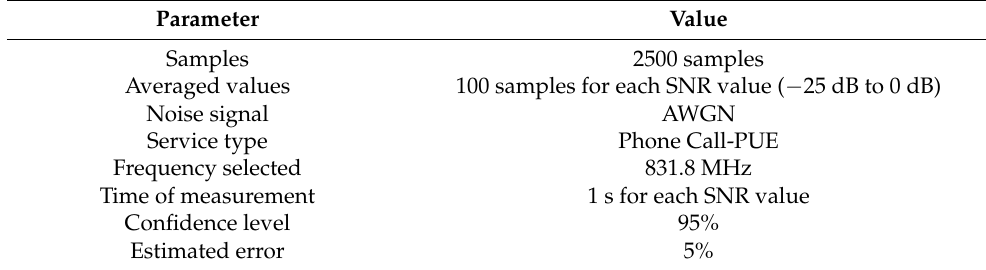
Table 2. Experimental parameters for the learning process.